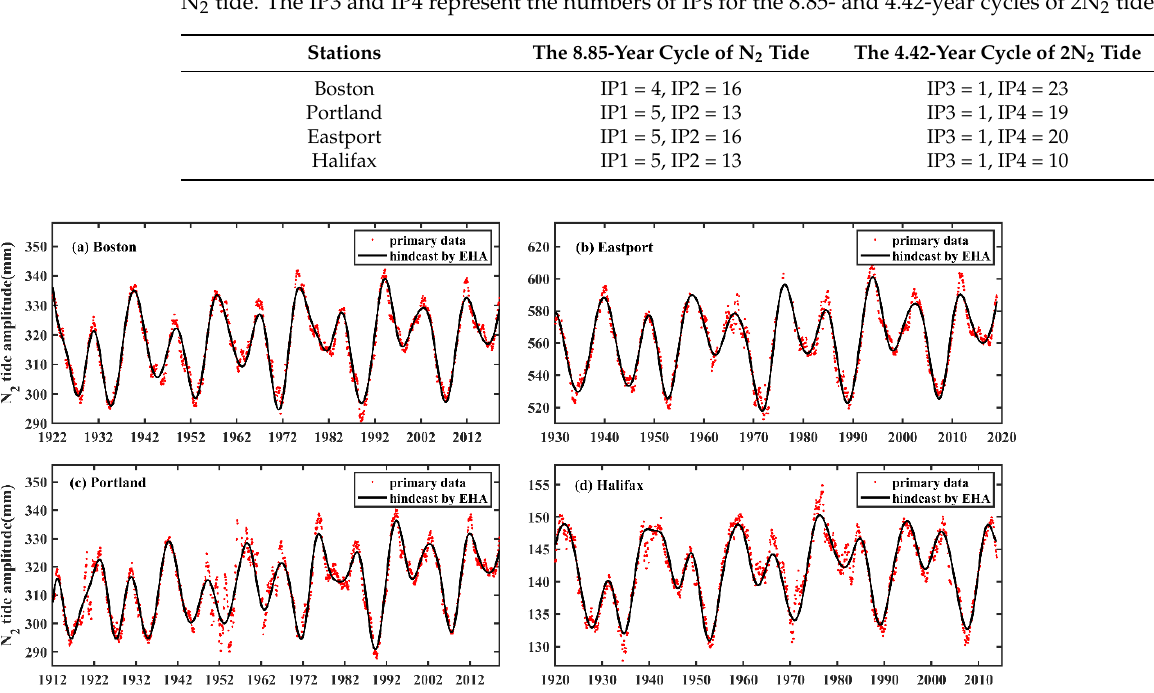
Figure 3. Same as Figure 2 but for the 2N 2 tide.